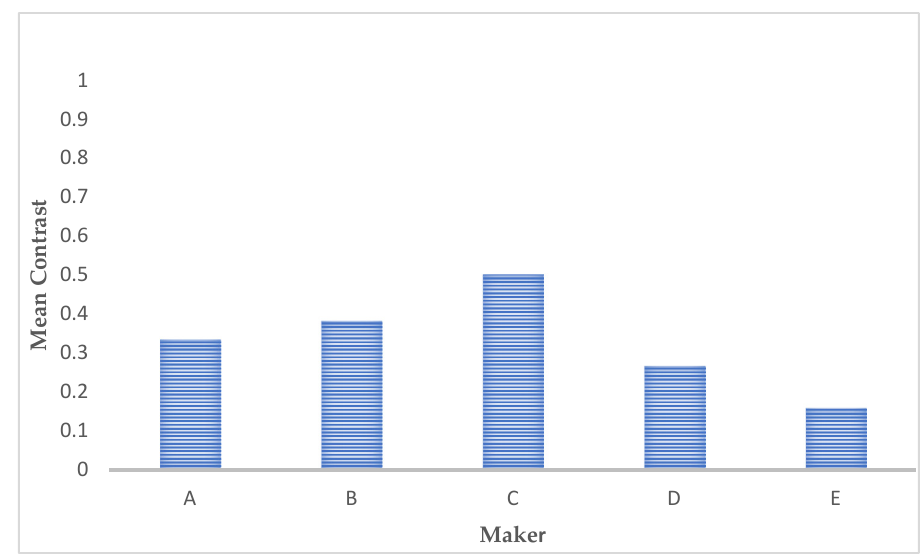
Make r Figure 8. Comparison of the contrast values presented by the di ff erent microstructure images. Figure 8. Comparison of the contrast values presented by the different microstructure images. Materials 2019 , 12 , x FOR PEER REVIEW 9 of 15 The average energy values of the di ff erent microstructure images are reported in Figure 9: Higher The average energy values of the different microstructure images are reported in Figure 9: Microstructures with the highest energy values are those with the highest degree of values correspond to homogeneous microstructures; this means that the di ff erences in gray values are Higher values correspond to homogeneous microstructures; this means that the differences in gray homogeneity; while those with lowest energy values are the microstructures with the most almost zero in most areas. Low values are found when di ff erences are evenly distributed spatially. values are almost zero in most areas. Low values are found when differences are evenly distributed appreciable presence of the above-mentioned metallurgical features. spatially.